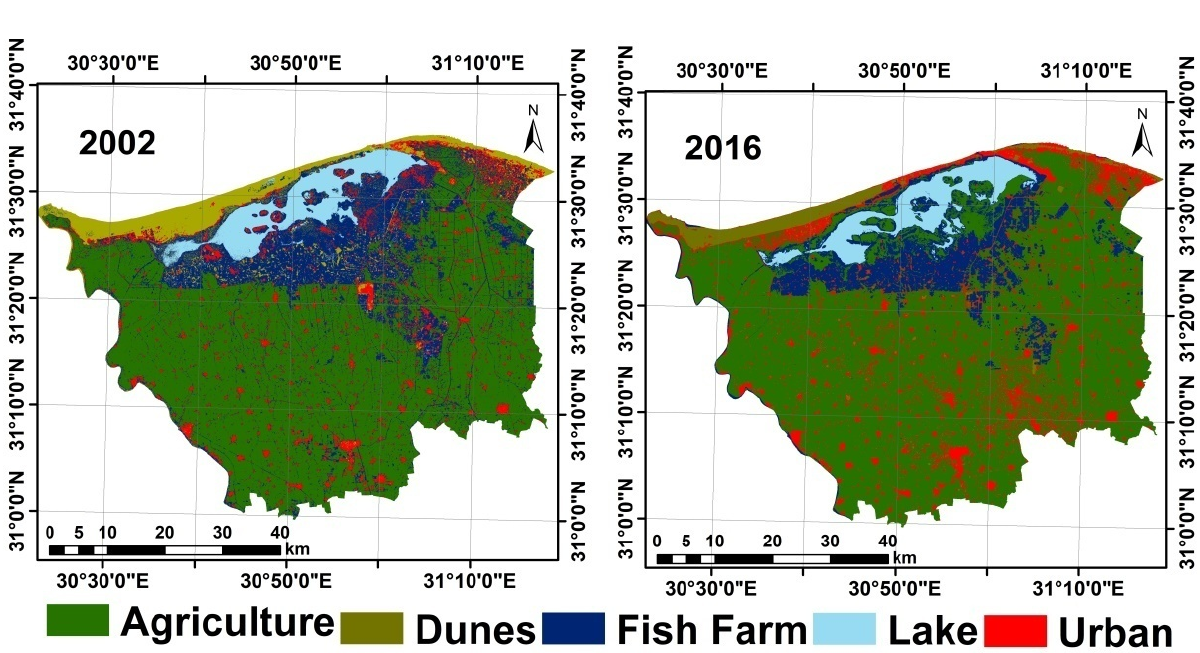
Figure 4. The land use/land cover classification maps in years of 2002 and 2016.